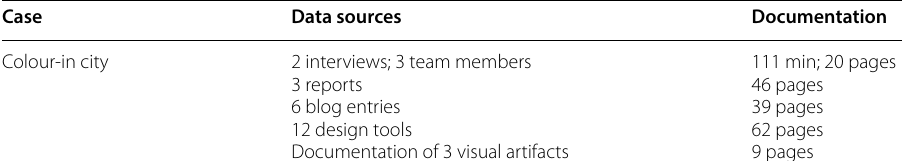
Table 9 Colour-in city data sources Case